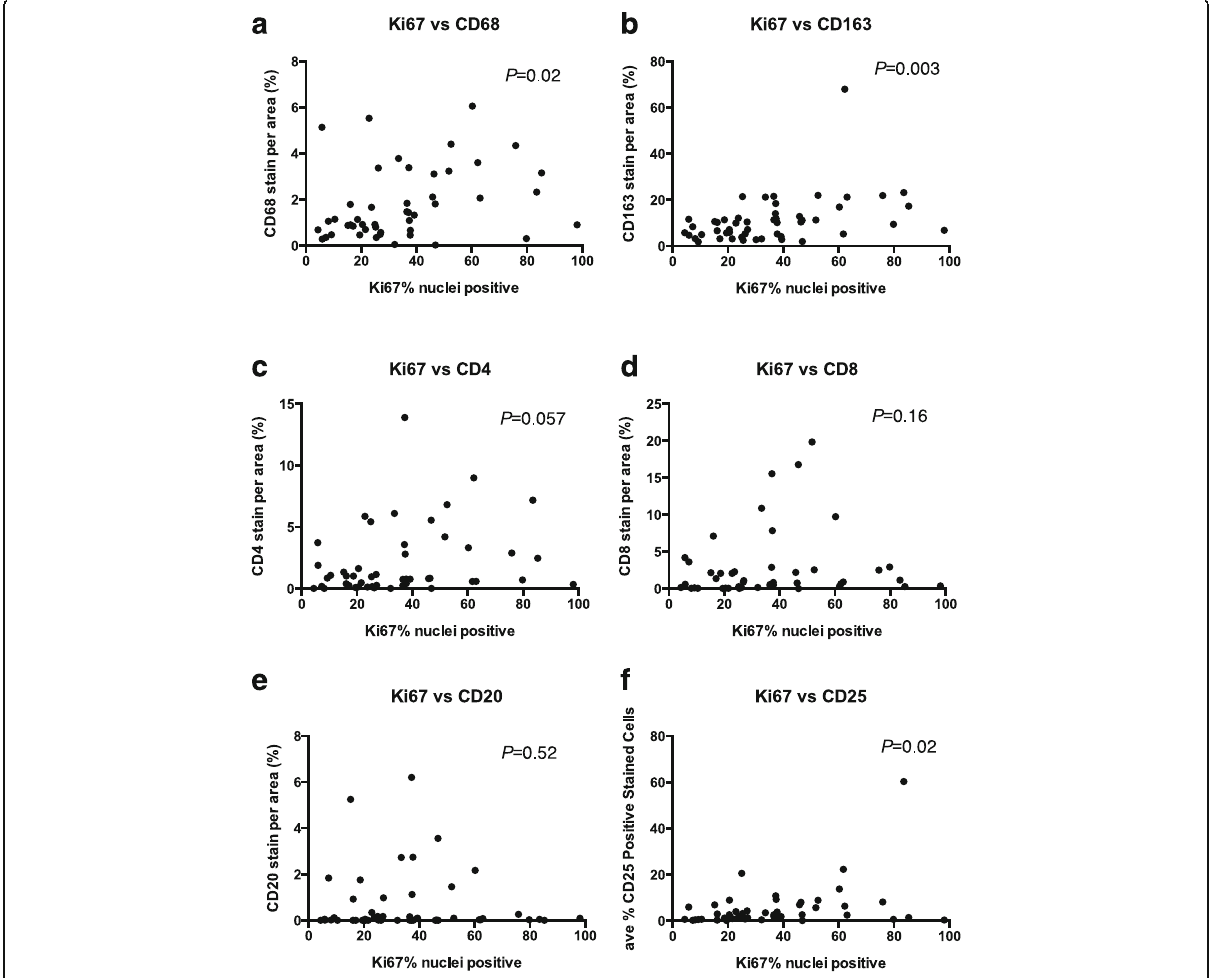
Fig. 2 Ki-67 and TIL density correlate in breast tumors from Kenya. Breast cancer tissue samples were stained for TILs, including CD68, CD163, CD4, CD8, CD20, and CD25. Each sample was scored for percentage of positively stained area for the indicated TIL. The Ki-67 positively stained areas/nuclei then were compared across TIL expression levels of CD68 a , CD163 b , CD4 c , CD8 d , CD20 e , and CD25 f by Spearman correlation ( P = 0.02, 0.003, 0.057, 0.16, 0.52, and 0.0096 with r = 0.3419, 0.4023, 0.2741, 0.2140, 0.09378, and 0.3704,